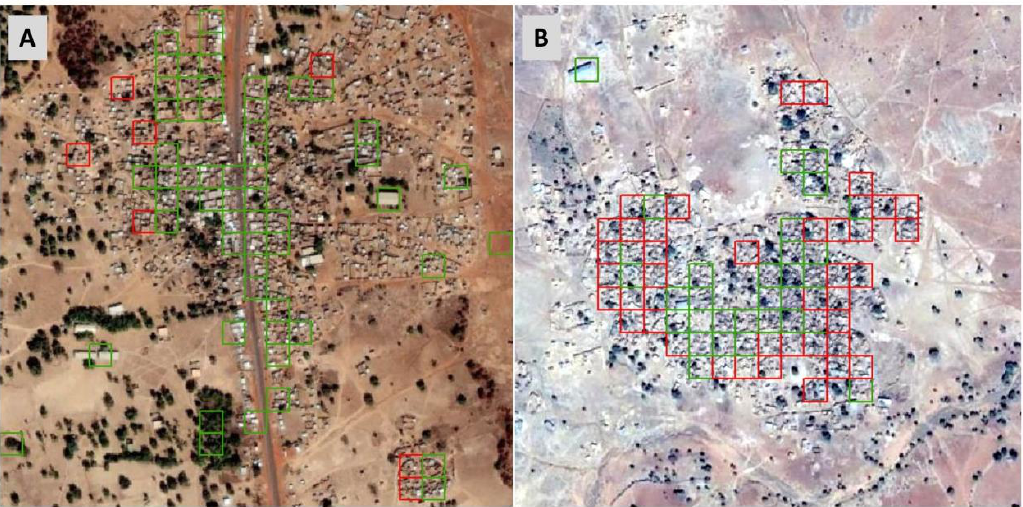
Figure 6. Examples of correctly (green) and incorrectly (red) classified pixels (30 × 30 m). ( A ) Extent near the Bissa mine with high accuracy. ( B ) Undetected urban pixels at the fringes of a settlement in Taparko area.